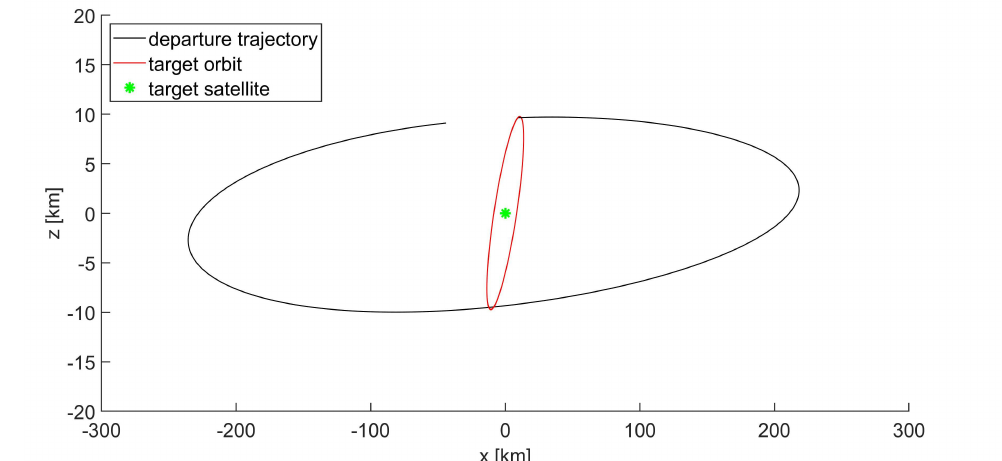
Figure 16. Guidance strategy: projection of the trajectory onto the [ ˆ x ˆ z ] plane; the amplitude of the z component does not change after the